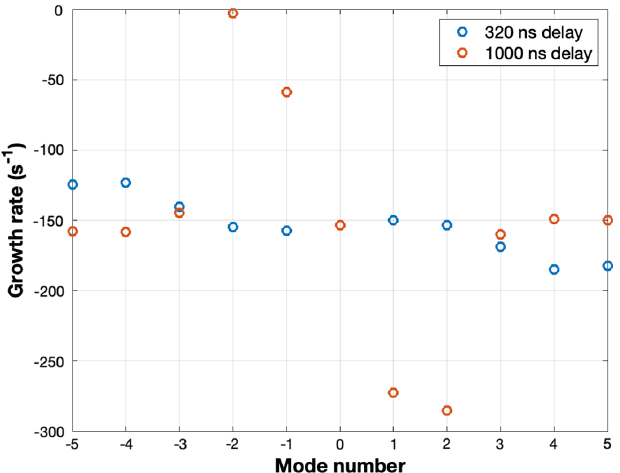
FIG. 22. Growth rate estimates for 10 GeVelectron ring for 320 and 1000 ns